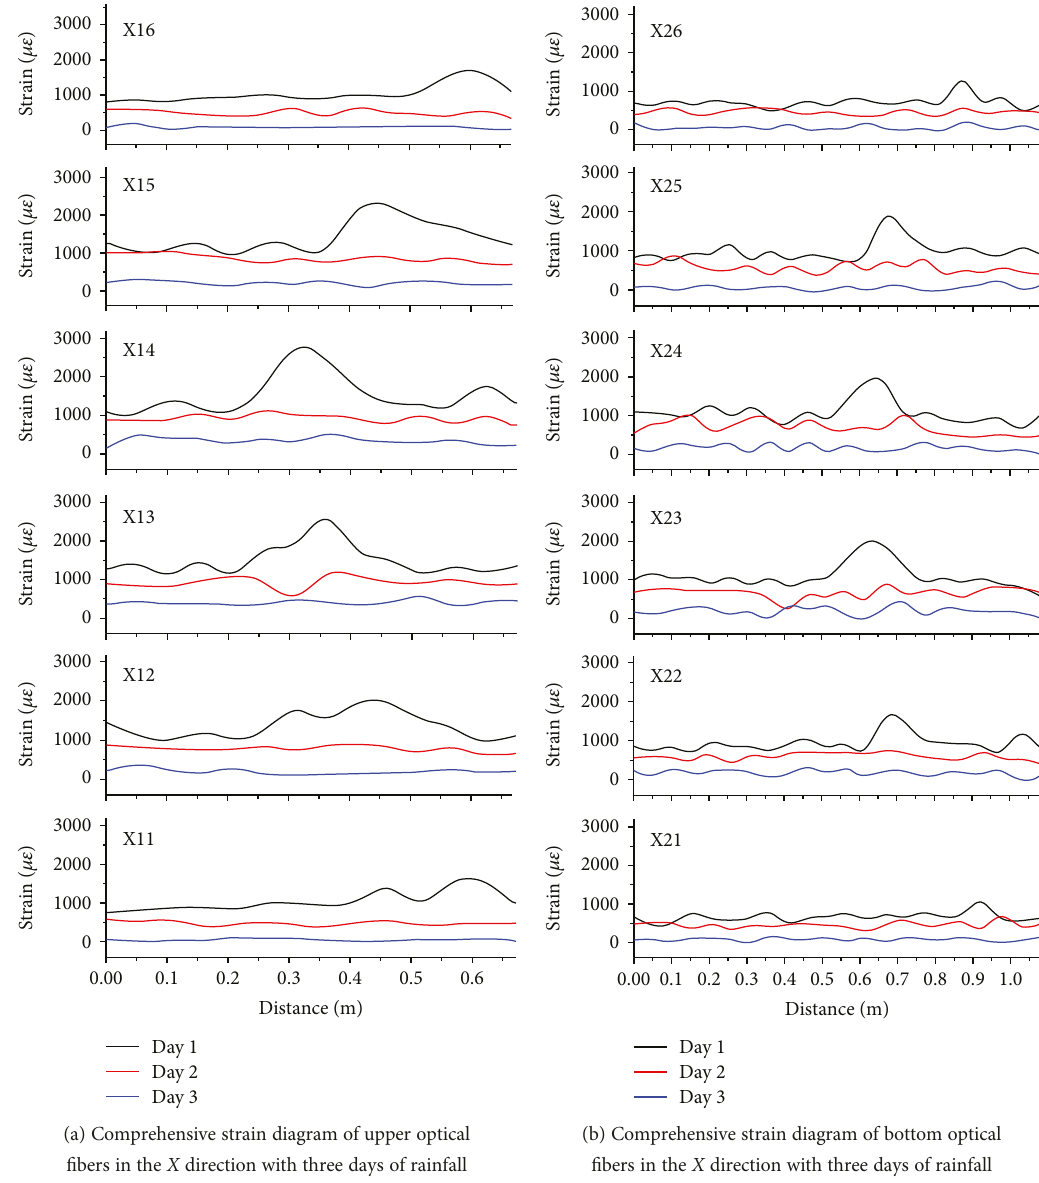
Figure 12: Comprehensive strain diagram of optical fi bers in the X direction with three days of